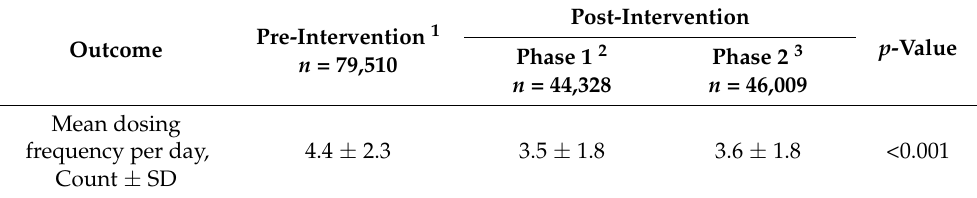
Table 2. ANOVA for the mean dosing frequency per day